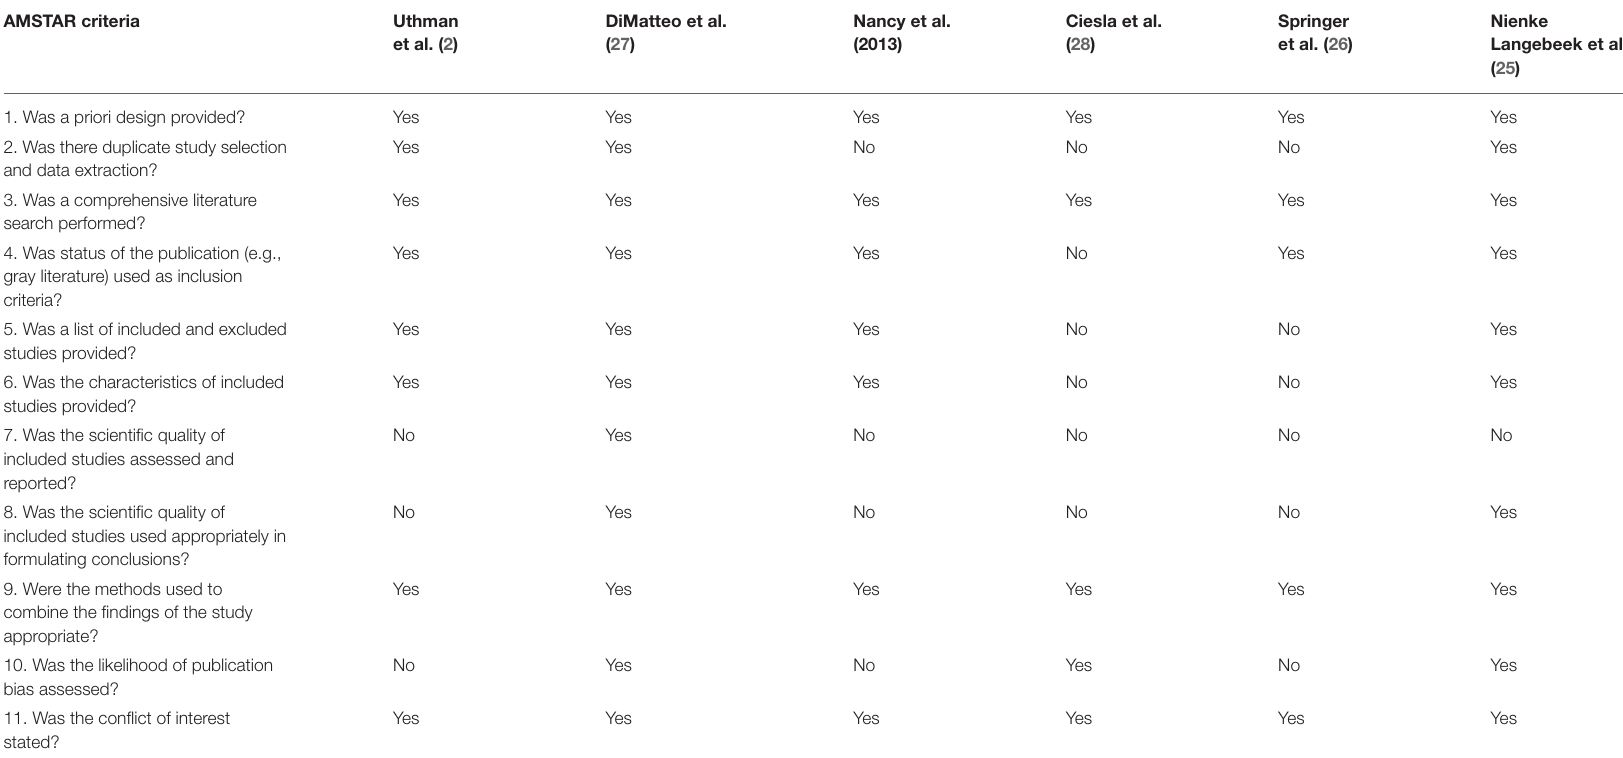
TABLE 4 | AMSTAR score of included reviews on effect of depressive symptoms on medication non-adherence among HIV/AIDS patients included in this systematic review of reviews. AMSTAR